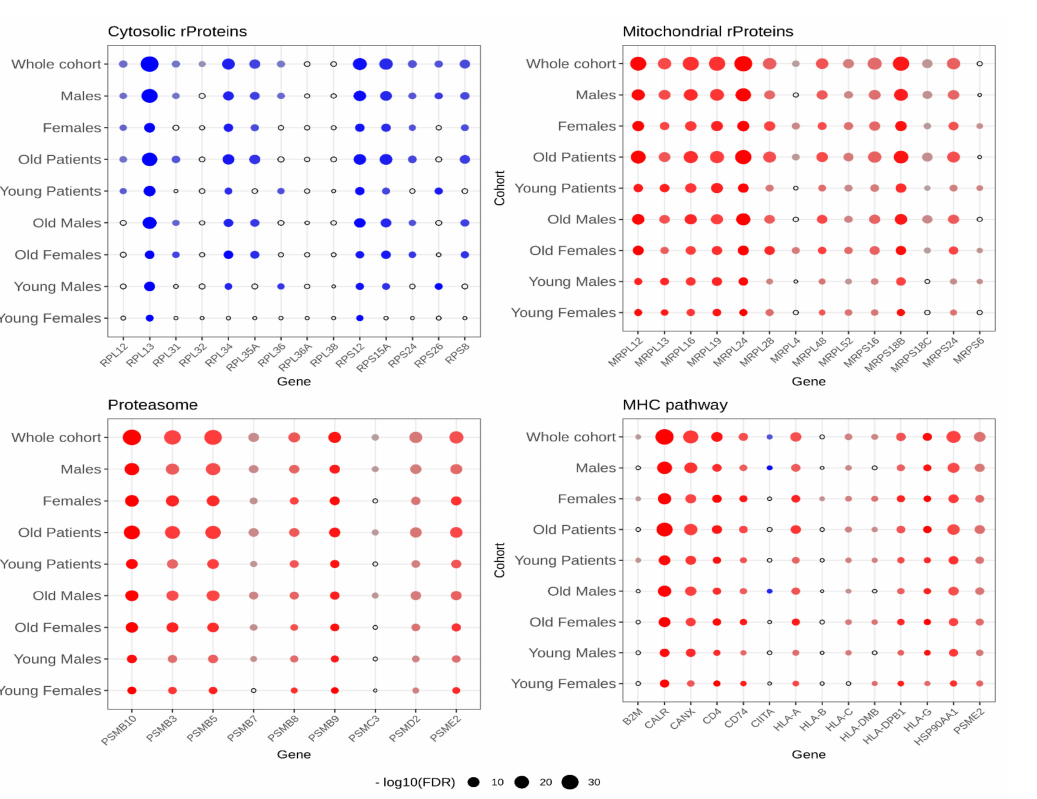
Figure 6. Differential gene expression between healthy GTEx samples and cancer TCGA samples . The four gene sets under investigation are shown in different panels. The overall cohort was divided into nine sub-cohorts: all samples, only males or females, only old (>50 years of age) or young, and combinations of sex and age. The size of each dot is proportional to the − log 10 (FDR) score for each statistical test. The colour and colour intensity of each point are proportional to the fold change of that comparison: red dots for upregulated genes (in tumour compared to healthy tissues), and blue dots for downregulated genes. Both colour and point size scales are independent for each gene panel. The lower legend is indicative of the overall trend of the